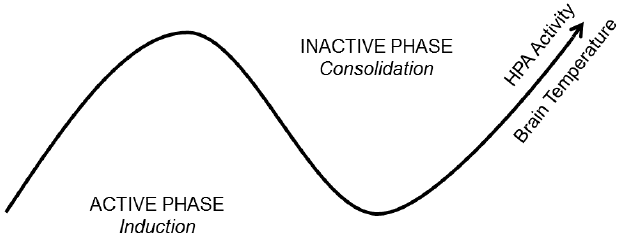
Figure 2. A State-Clock Model (SCM) of sleep and circadian regulation of synaptic plasticity.